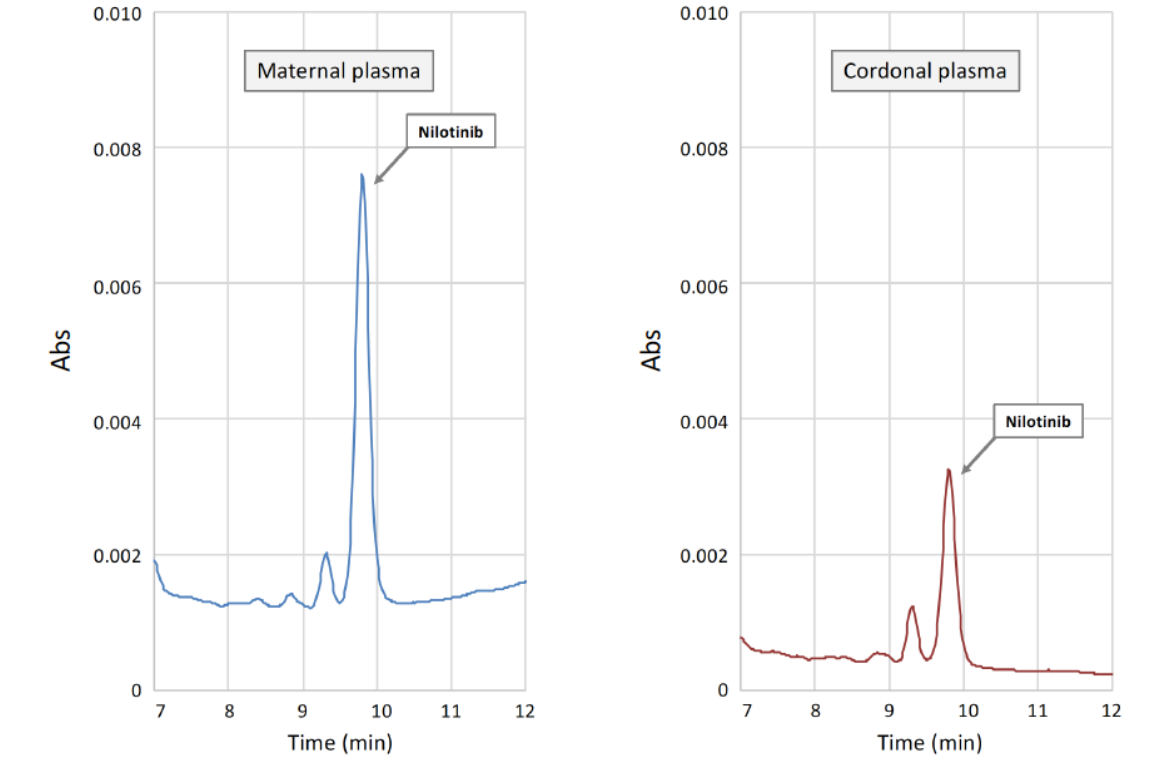
Figure 1. Representative chromatograms obtained from the UV-HPLC analysis of plasma samples obtained from maternal ( left ) and cord ( right ) blood in patient # 10 showing little (~0.33%) transfer of the drug.